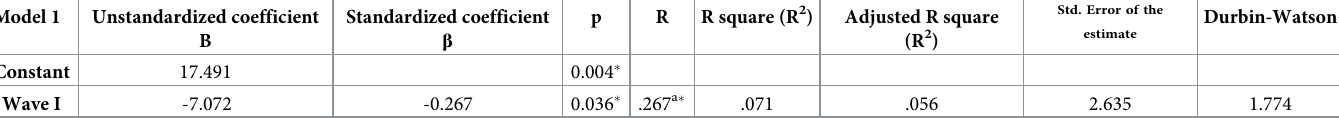
Table 4. Multiple regression analysis of TSH (dependent variable) with wave I, wave III, wave V, intervals I-III, III-V and I-V (independent variables) in a stepwise model. Model